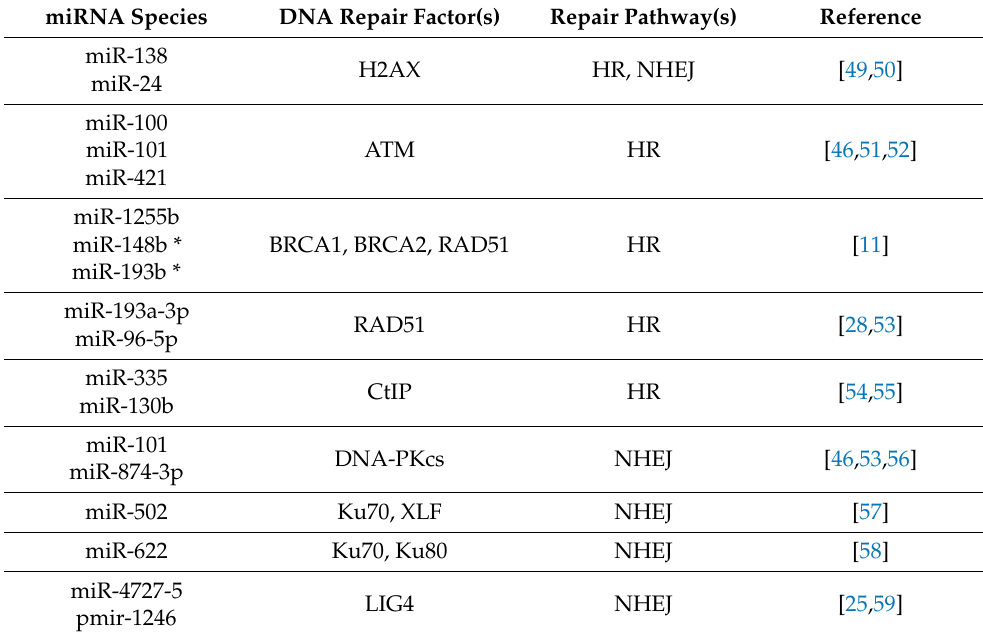
Table adapted from Thapar, 2018 [4]. The * is part of the species name given in the